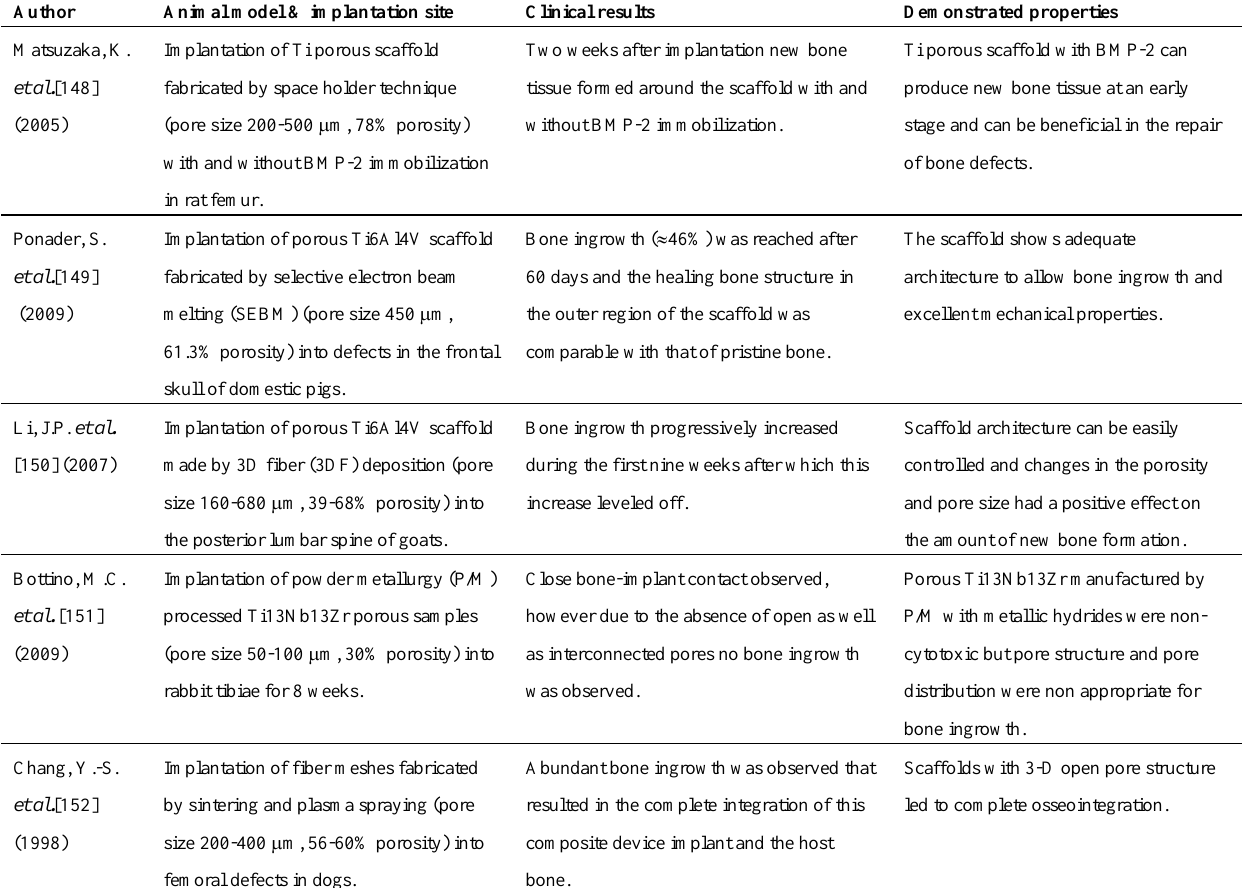
Table 9. Preclinical studies using Ti